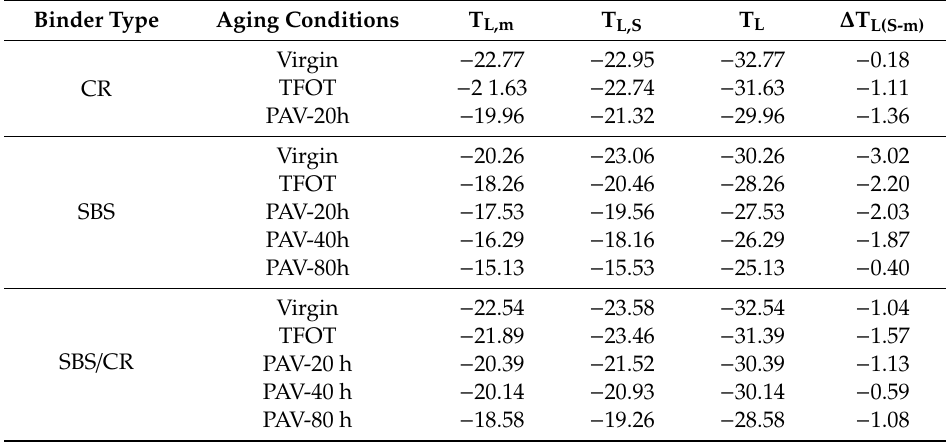
Table 4. PG Low temperature of BBR test for all tested